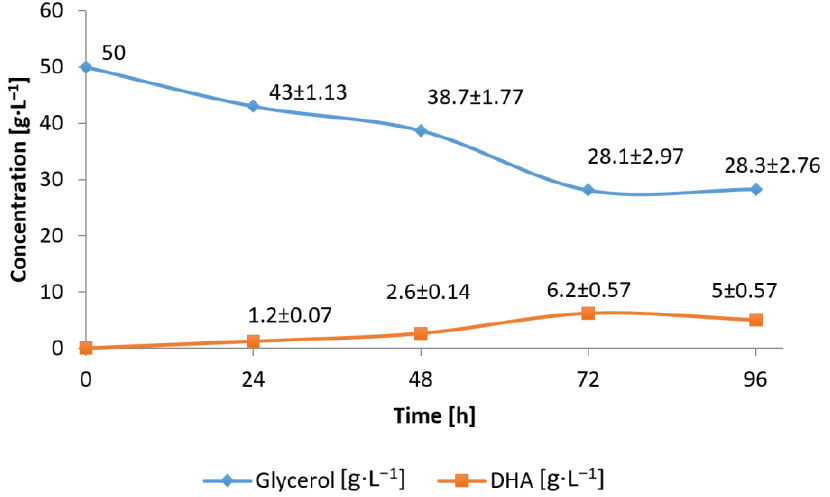
Figure 9. Time profiles of glycerol conversion and DHA formation during bioconversion of 50 g · L − 1 of a waste glycerol fraction with immobilized cell extract obtained from G. oxydans Reaction with 50 g·L −1 initial waste g l ycerol concentration and free cell extract resulted in low consumption of g l ycerol (only 5 g·L −1 and 7.5 g·L −1 after 24 and 48 h, respectively) (Figure 8). The final concentration of DHA successively increased throughout the reaction from about 4 g·L −1 (after 24 h),